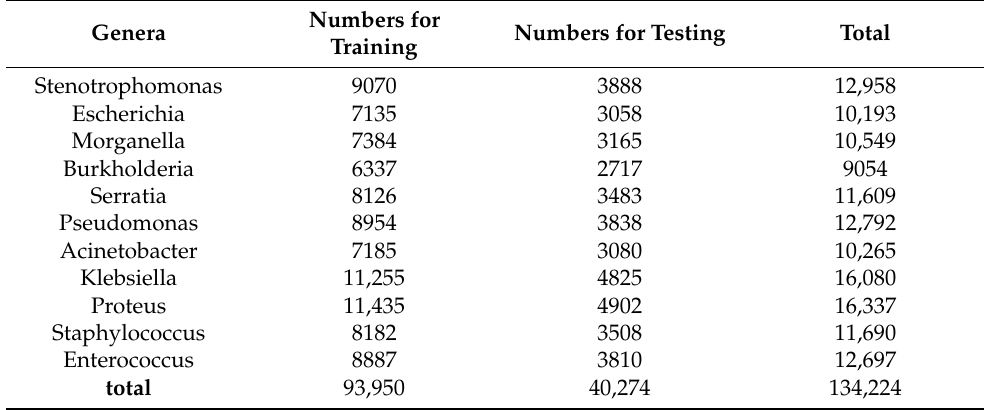
Table 1. The number of bacteria.